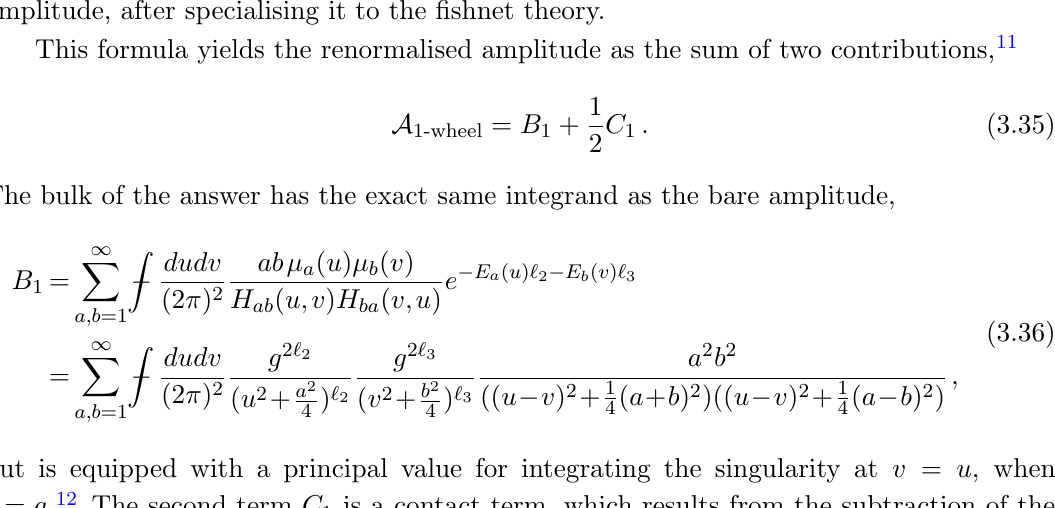
v . One (cid:0) v (cid:0) !